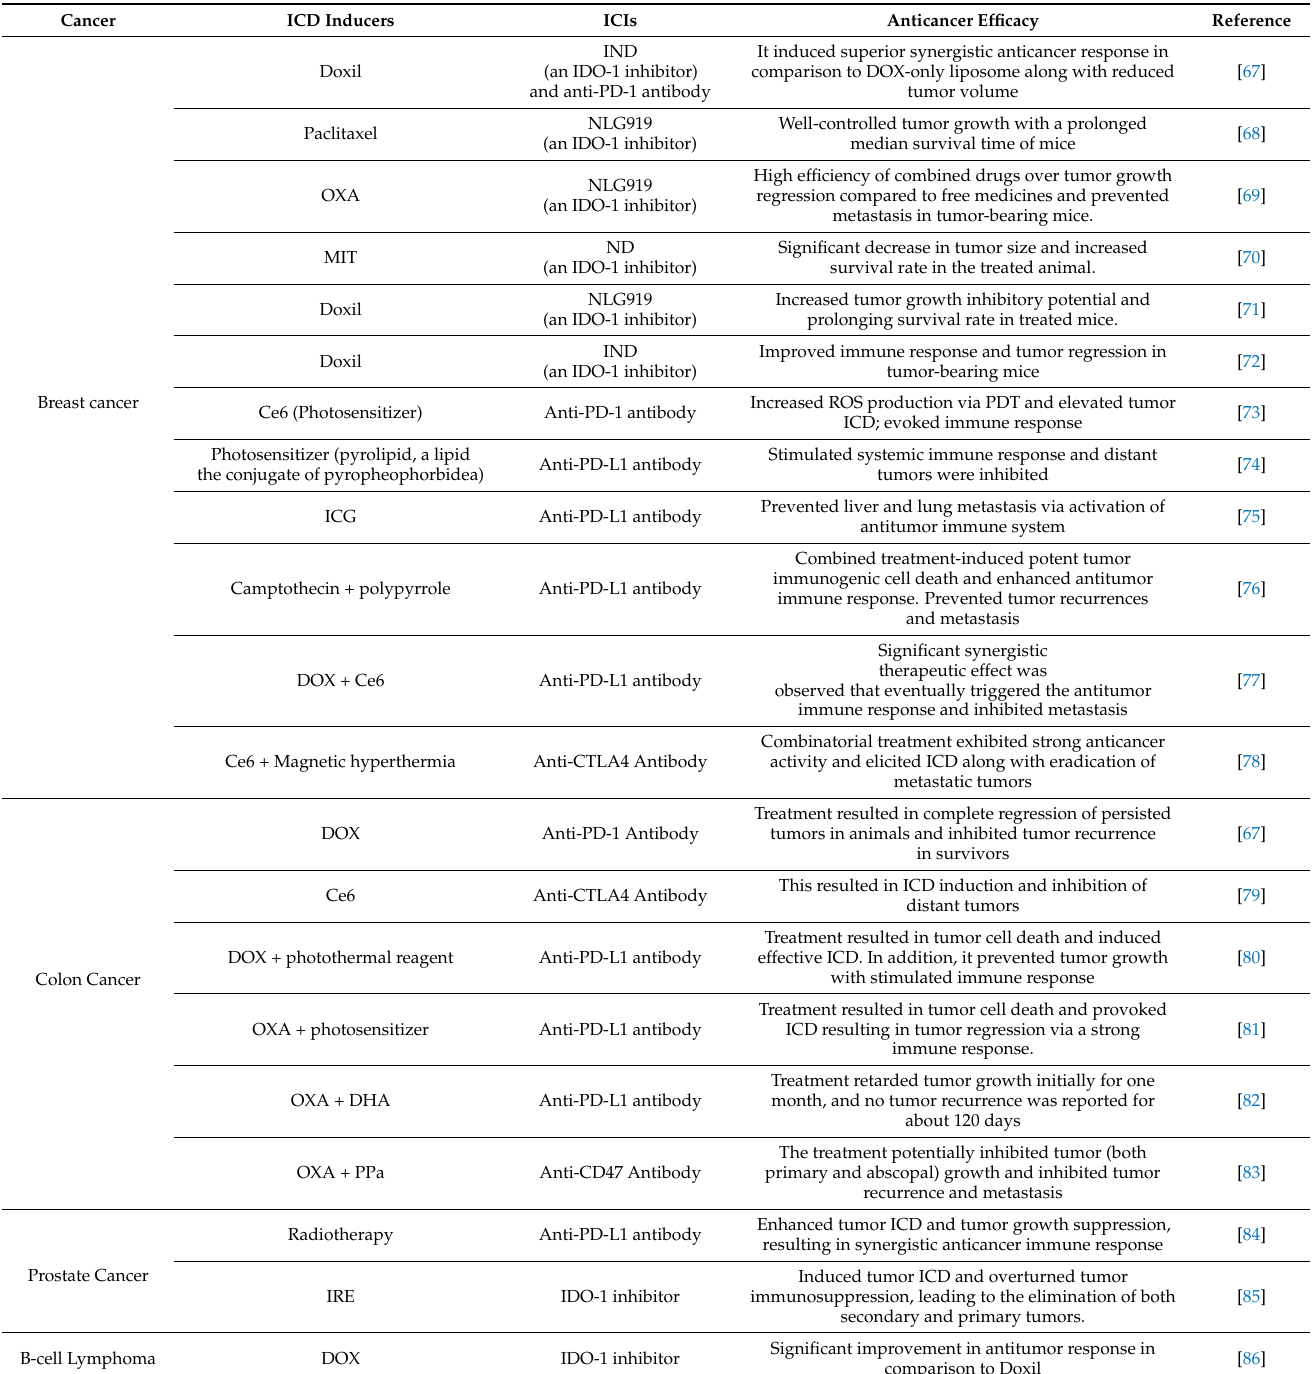
Table 4. ICD inducers in combination with immune checkpoint